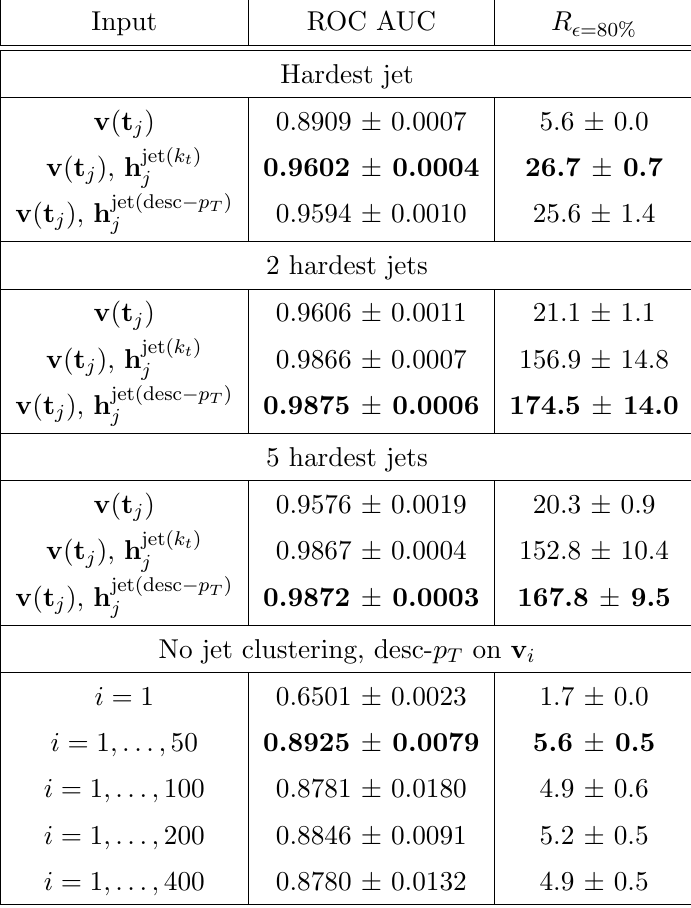
Table 3 . Summary of event classi(cid:12)cation performance. Best results are achieved through nested recurrence over the jets and over their constituents, as motivated by